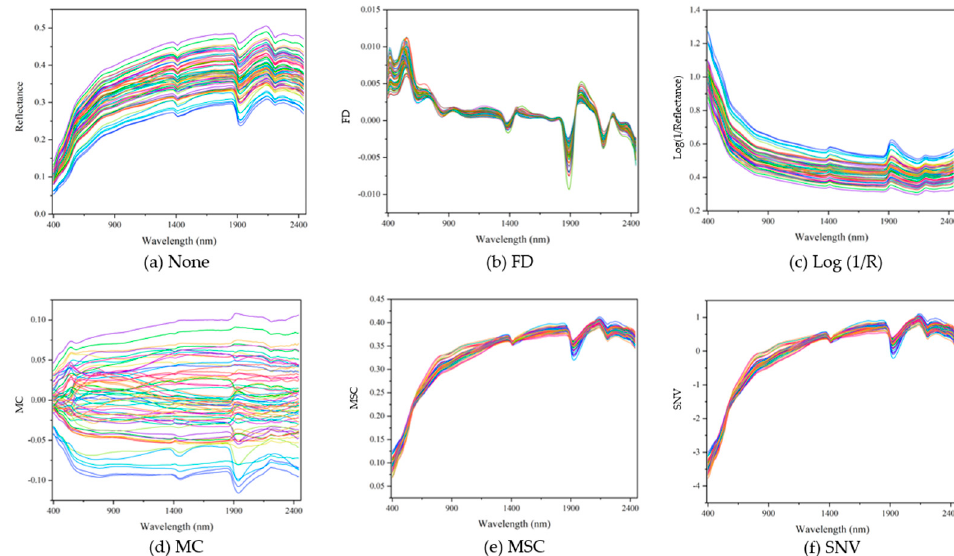
Figure 2. The raw and pretreated soil spectra. ( a ) None: raw spectra; ( b ) FD: the spectra after first derivative; ( c ) Log (1 / R): the absorption spectra; ( d ) MC: the spectra after mean centering; ( e ) MSC: the spectra after multiplicative scatter correction; and ( f ) SNV: the spectra after standard normal variate.